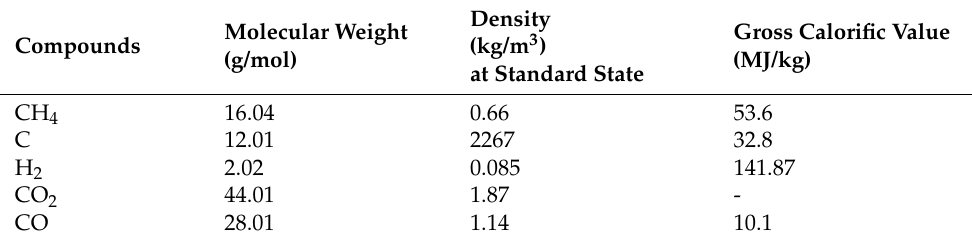
Table 1. The molecular weight, density, and calorific values of the compounds.